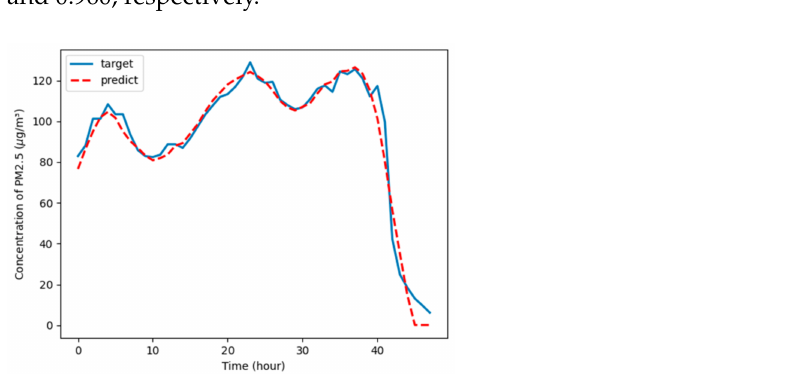
Figure 8. Results of PM2.5 concentration prediction using the CNN-BiLSTM-Attention model. Table 4. The MAE, RMSE (Unit: µ g/m 3 ), and R 2 of the 10 randomized trials of the proposed model.